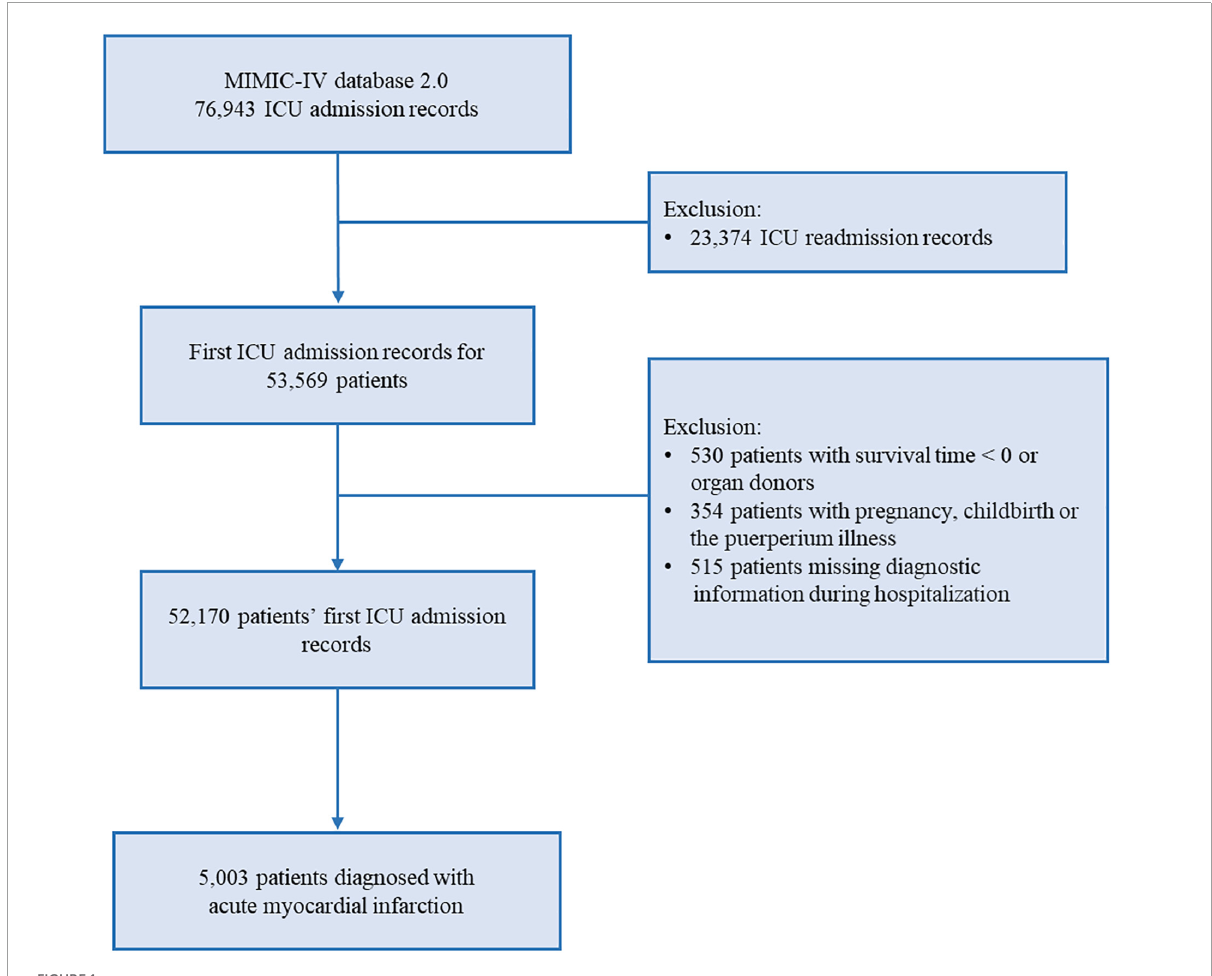
FIGURE1 Flowchart of the detailed participants selection